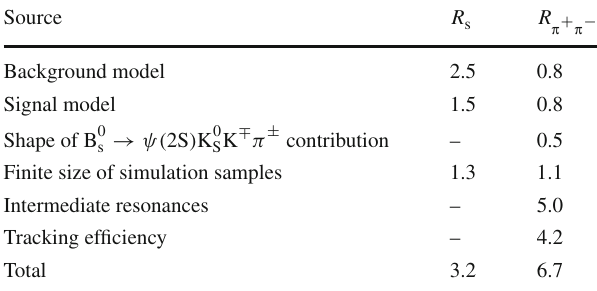
Table 1 Systematic uncertainties (in %) of the measured branching fraction ratios